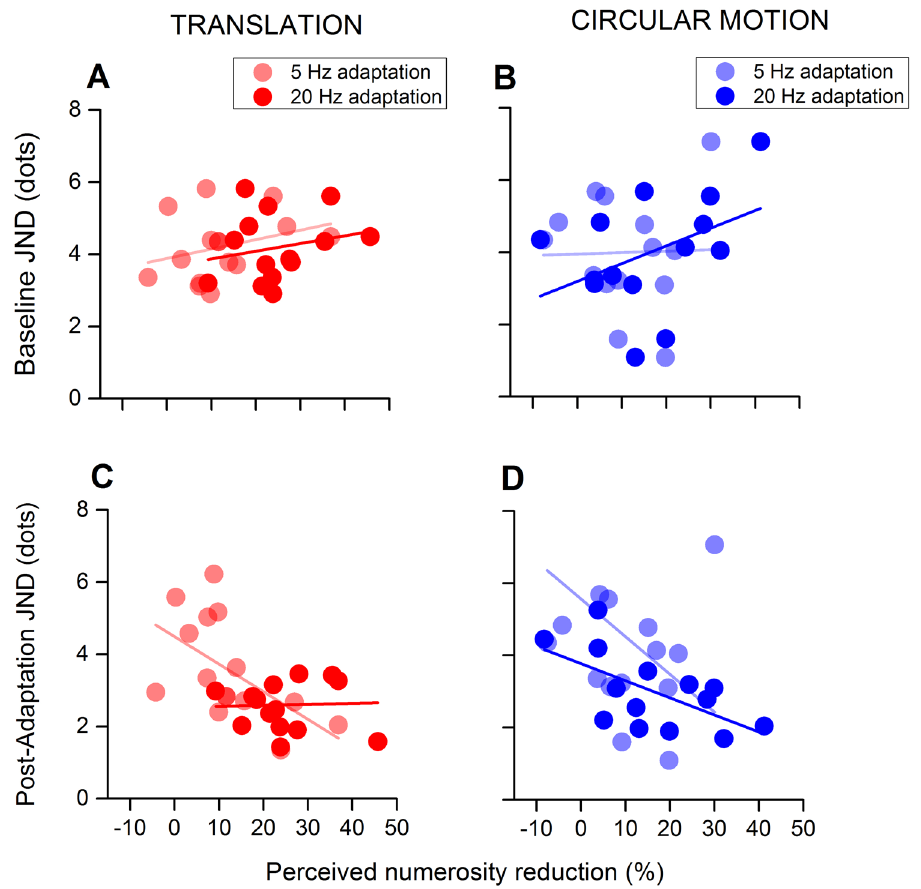
Figure 4. The relation between baseline and post-adaptation JNDs and adaptation effects. ( A , B ) Pre-adaptation (baseline) sensitivity for numerosity discrimination (JND) plotted as a function of post adaptation numerosity reduction for ( A ) translational and ( B ) circular motion. None of the correlations concerning baseline JND turned out being statistically significant, suggesting independency between precision in numerosity discrimination and susceptibility to motion adaptation. ( C,D ) Correlations between post-adaptation JND and adaptation magnitude for translational and circular motion ( C and D respectively). In most cases post-adaptation JNDs negatively correlated to the magnitude of the adaptation to indicate a concurred reduction of PSEs and JNDs. This in turn reflect an increase in precision for lower perceived magnitude in line with Weber’s